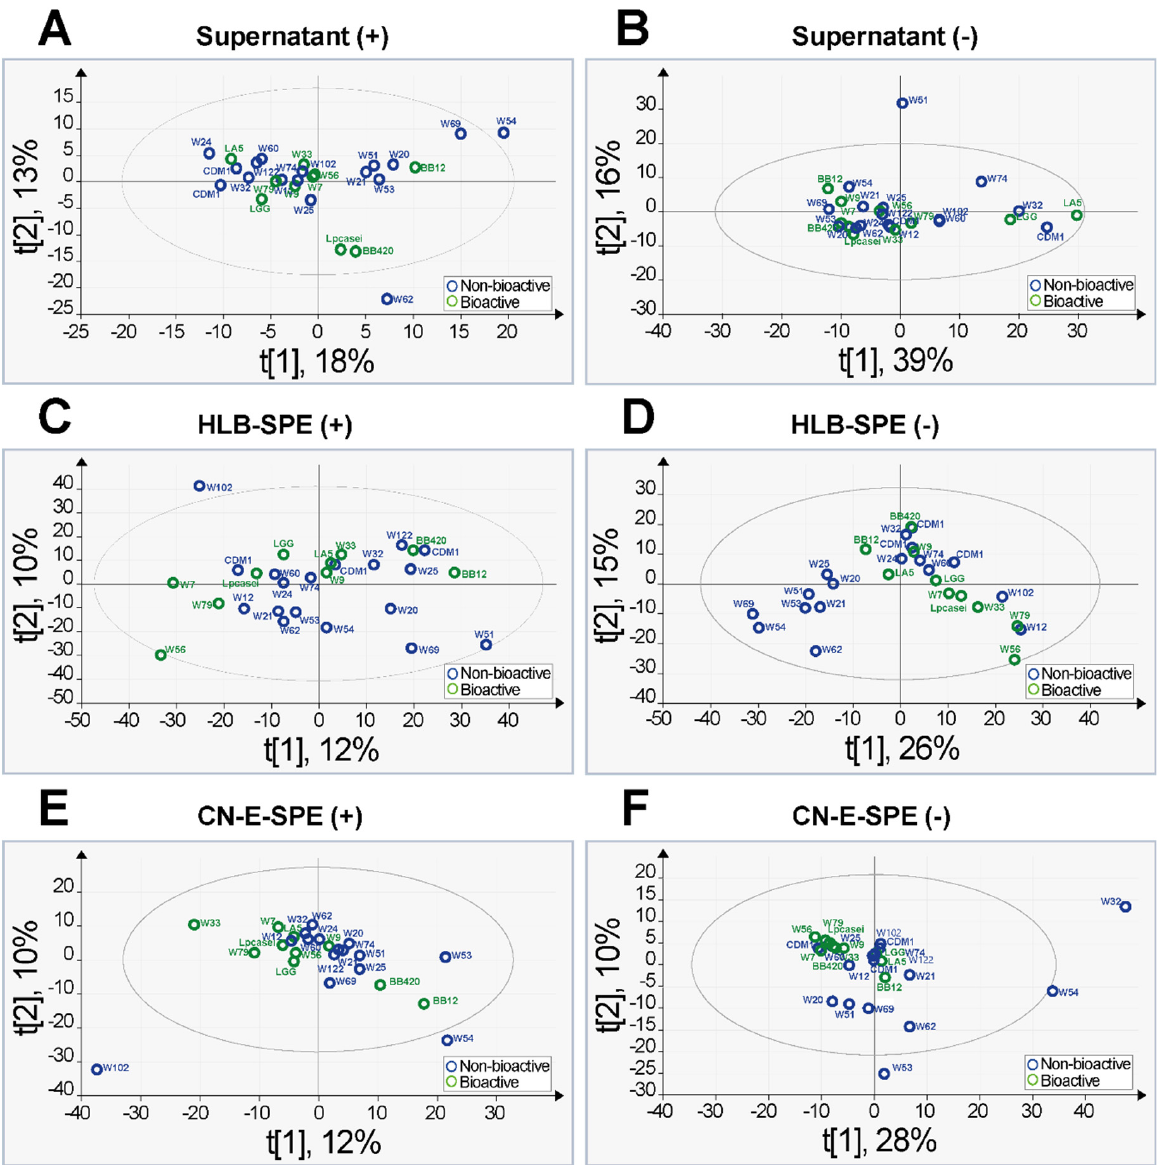
Figure 2. Unsupervised PCA scores plots obtained from the data matrix of samples of crude probiotic supernatants ( A , B ), HLB-SPE extracts ( C , D ), and CN-E-SPE extracts ( E , F ). The left side displays results obtained from FT-ICR-MS analyses in ESI positive mode and the right side in ESI negative mode. Only models D and F showed a group separation trend with predictive relevance.